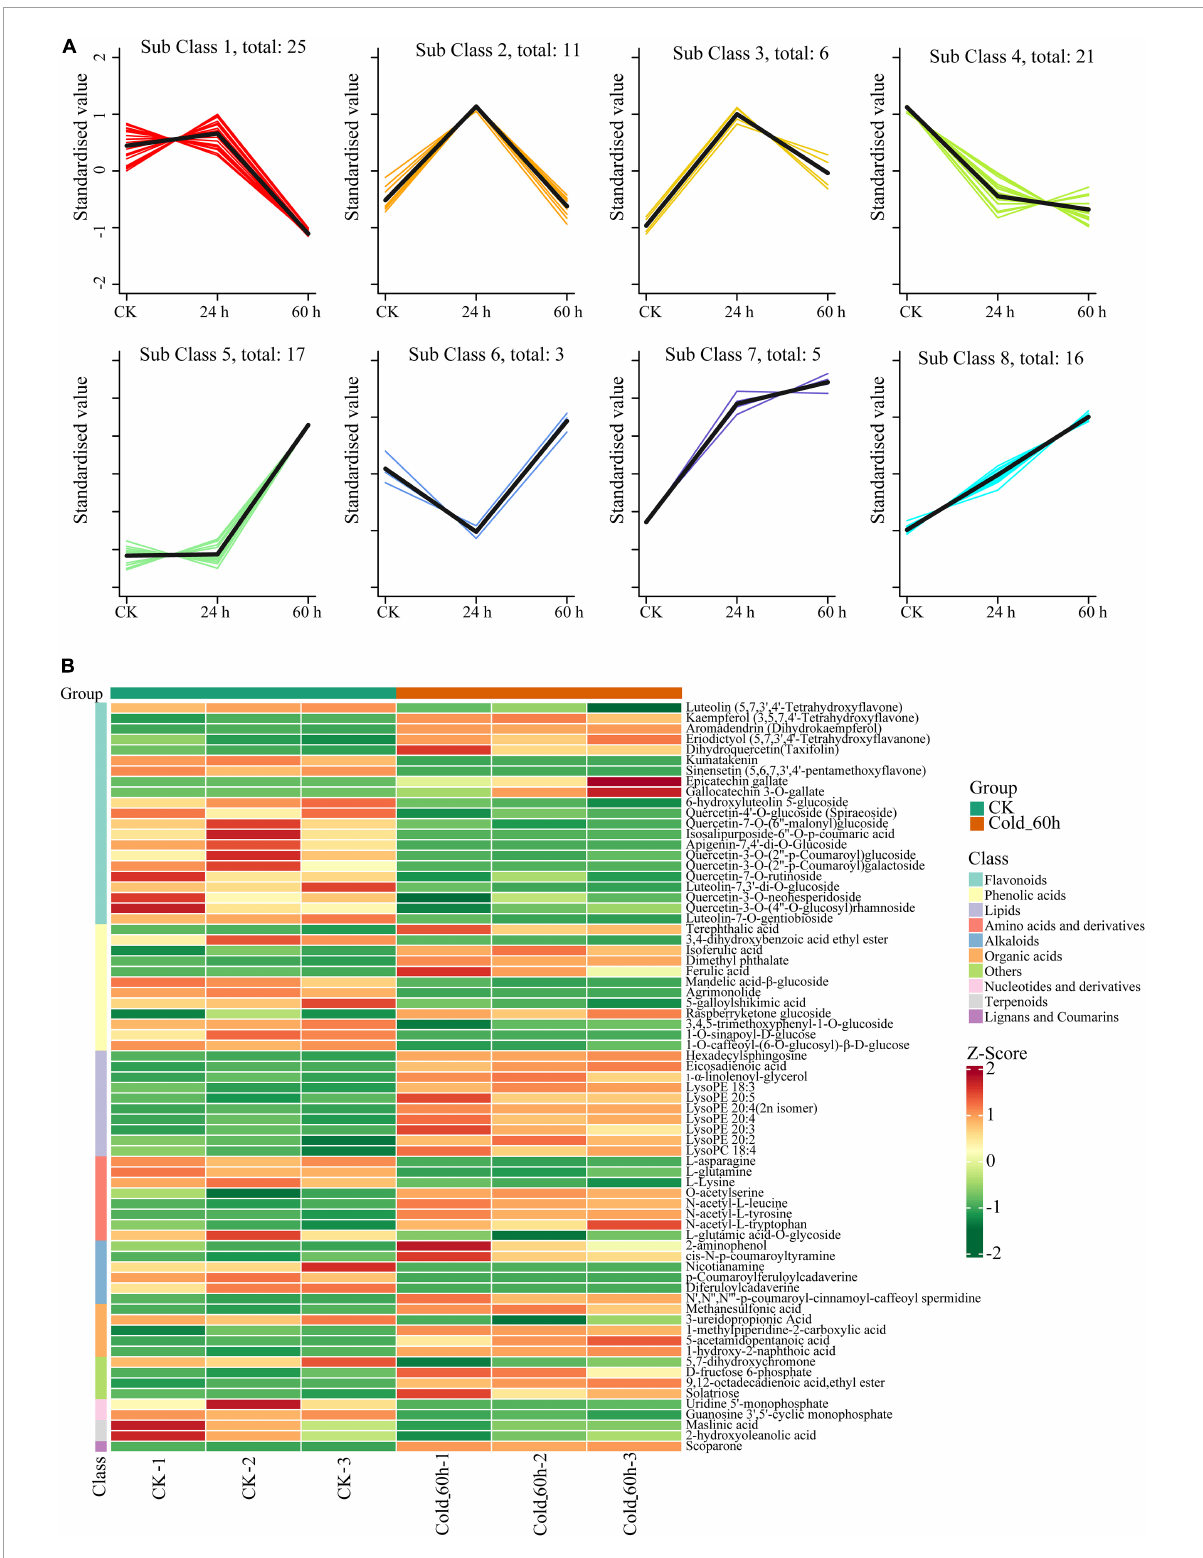
FIGURE4 Cluster analysis of significantly different metabolites in Pohlia nutans after cold stress. (A) k-means clustering algorithm analysis of metabolites. (B) Heatmap of significantly different metabolites sorted by metabolite classes in Pohlia nutans after 60 h of cold stress.